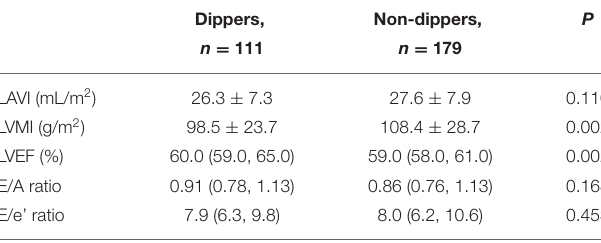
TABLE 3 | Conventional echocardiographic parameters. Dippers,